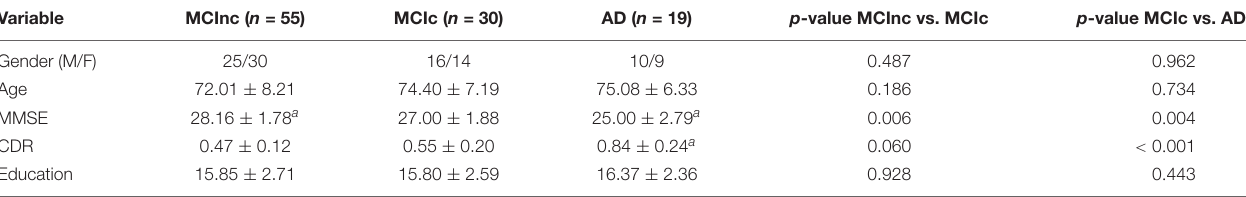
TABLE 1 | Characteristics of the